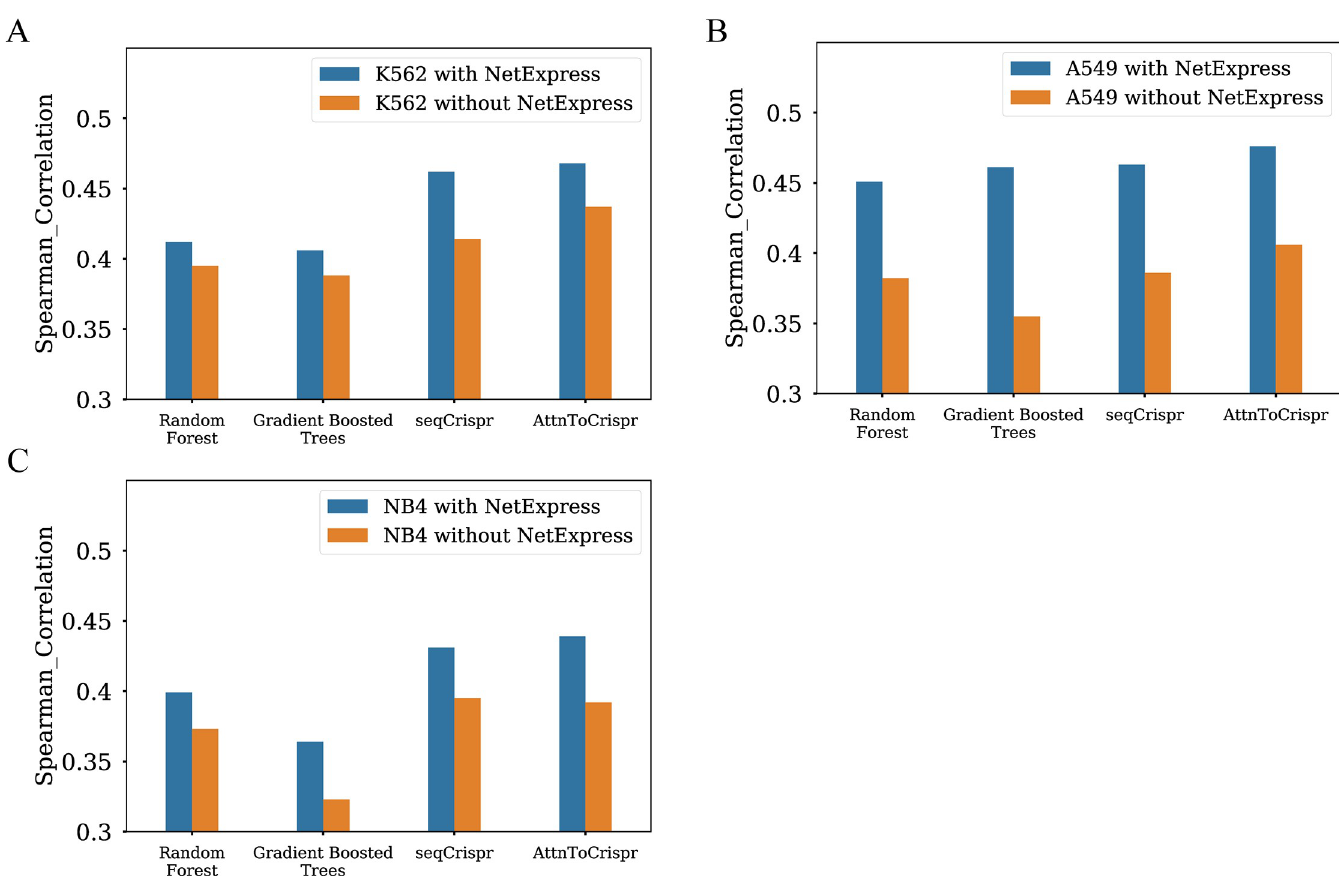
Fig 4. Performance comparison of models that are trained with or without NetExpress score. Spearman correlation metric is measured to test models performance on three negative selection experiment datasets. A) K562 cell line dataset. B) A549 cell line dataset. C) NB4 cell line dataset.